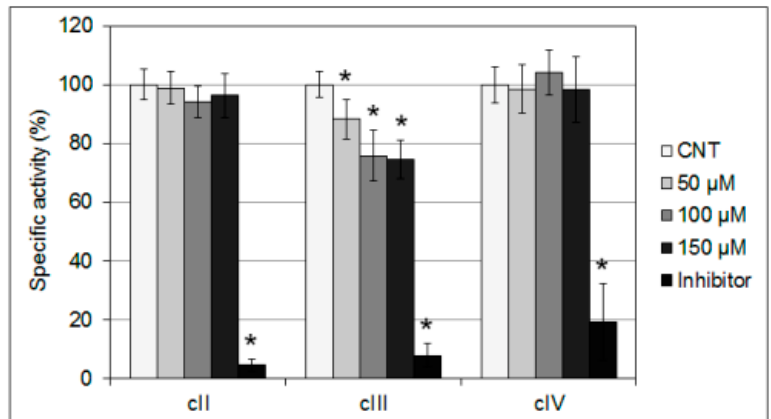
Figure 5. Respiratory chain complexes activity. Biochemical activities of succinate quinone DCPIP reductase (cII), NADH-cytochrome c oxidoreductase (cIII) and cytochrome c oxidase (cIV) were measured on a mitochondrial enriched fraction. mHtcum was added at increasing concentrations (from 50 to 150 µ M) and compared to DMSO treated cells (CNT). Specific inhibitors for complex II (malonate), complex III (antimycin A) and complex IV (Na-azide) were used as control. Values were normalized to the control (CTN) and represented as the mean of three independent experiments ± S.D. (* p ≤ 0.05).